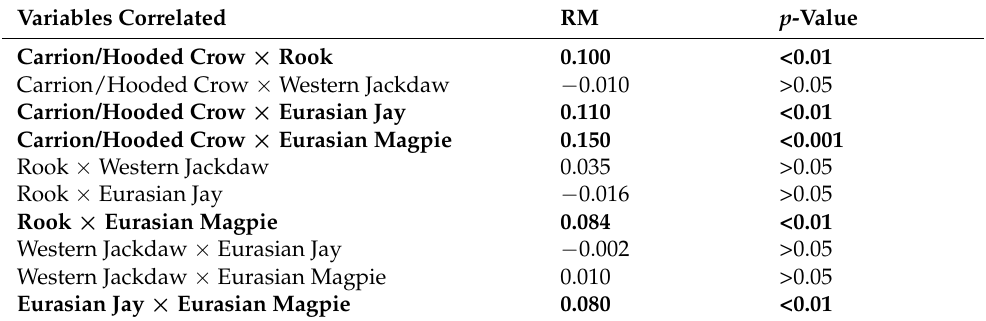
Table 1. Spatial overlap test. Results of Mantel tests between the spatial distributions of each pair of corvid species, with 999 Monte Carlo permutations. The table shows the statistic RM of the test and the simulated p -values. Values with a p -value < 0.05 are in